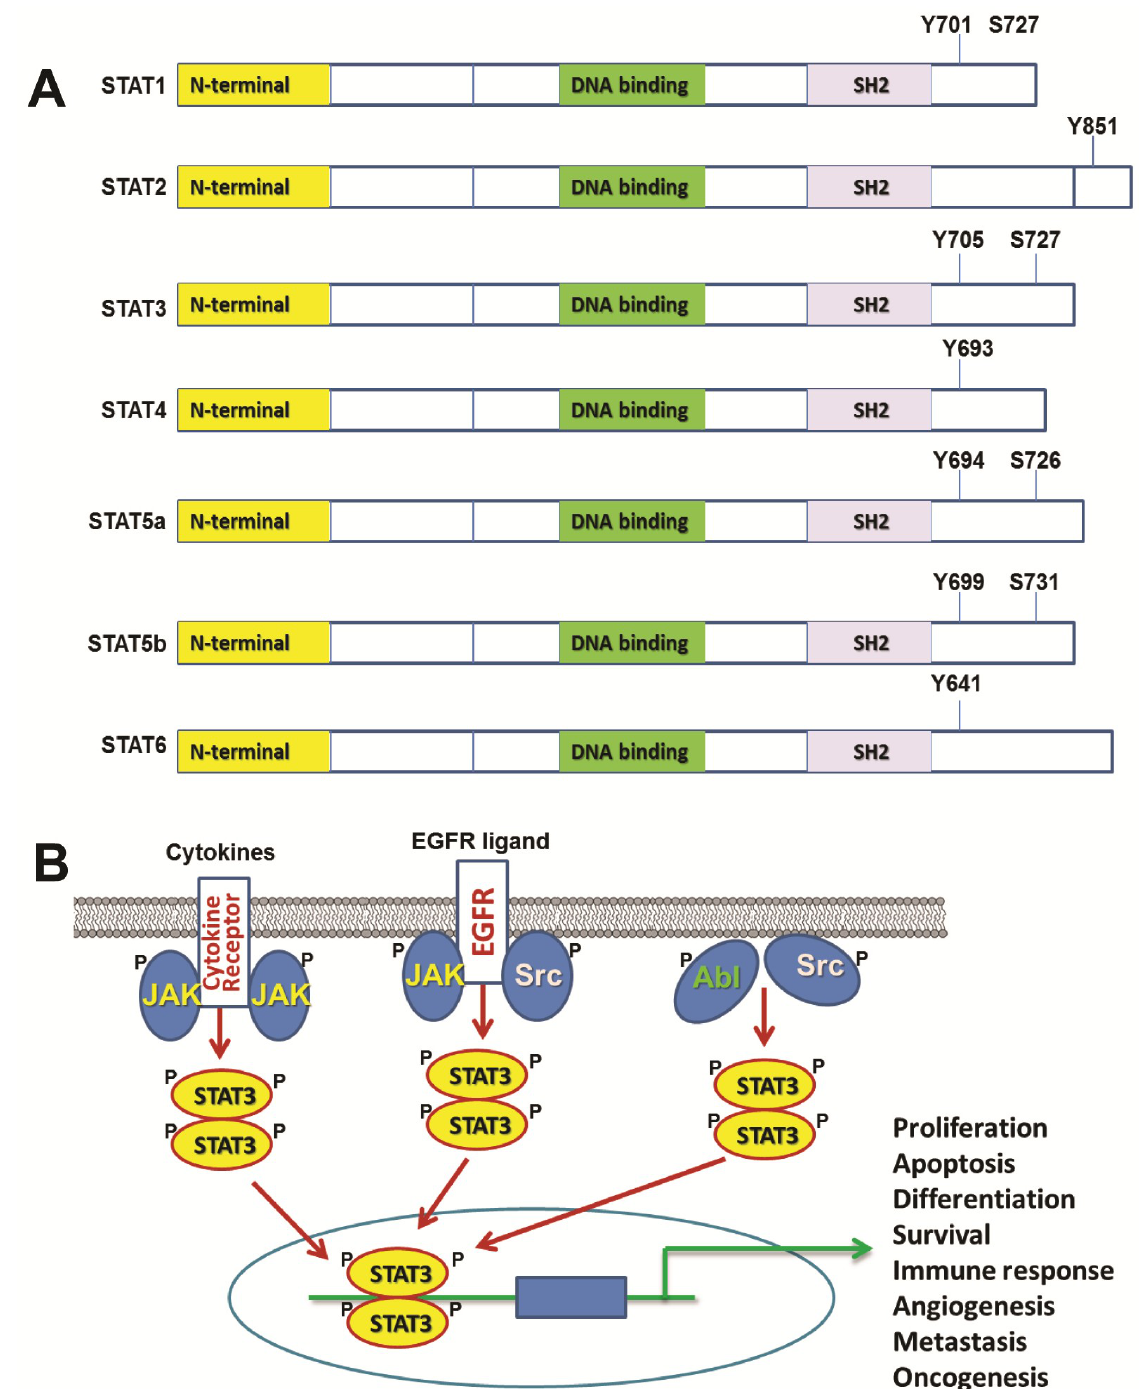
Figure 1. STAT family of transcription factors and STAT3 signaling pathway. ( A ) Structure and function domains for STAT1-6. ( B ) STAT3 signaling and its activation signals from extracellular and intracellular